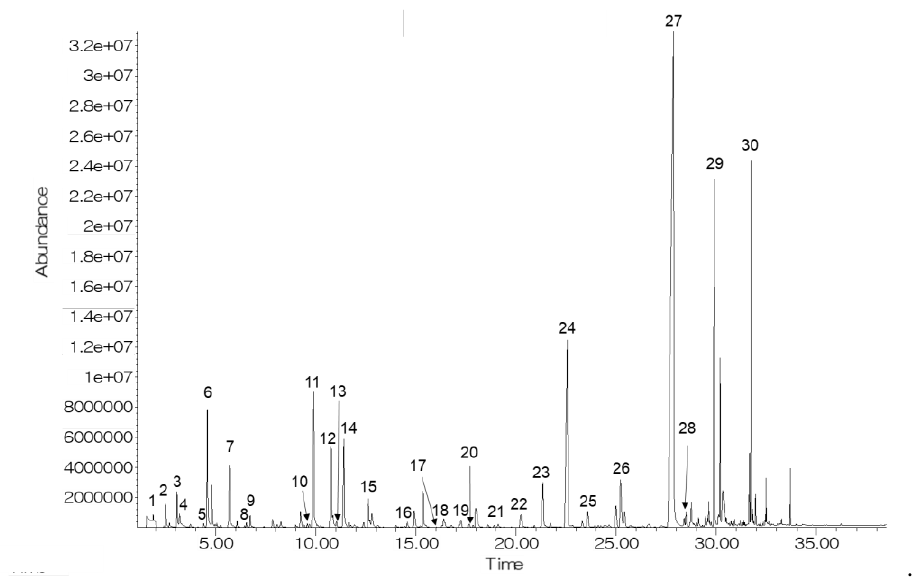
Figure 1. A representative GC chromatogram of CO 2 -treated bright-red strawberries after 9 d of storage at 10 °C. Volatile compound codes are provided in Table 1.